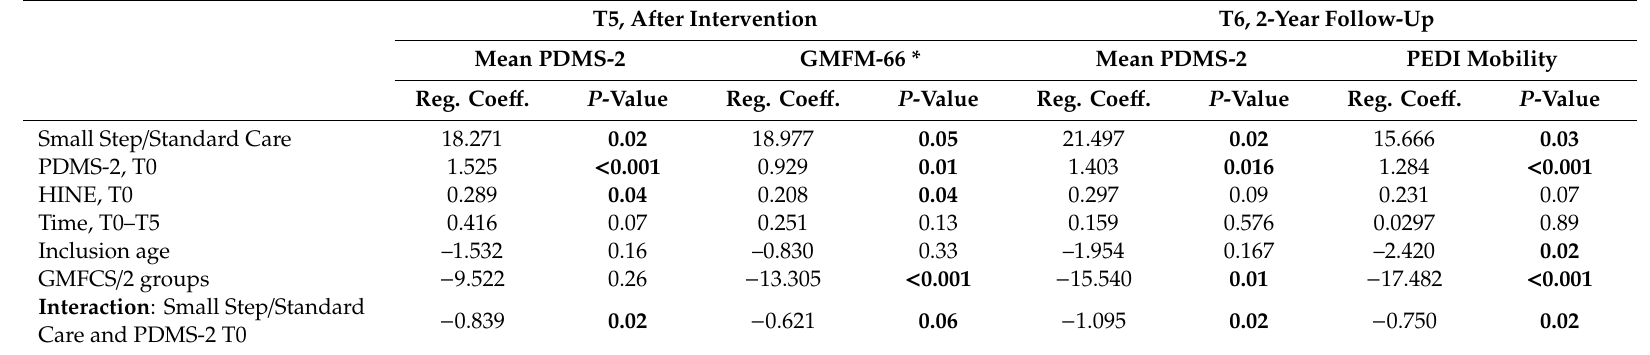
Table 3. Final linear model analysis with PDMS-2 as the outcome at post intervention (T5) and at 2 years of age (T6). The models for secondary outcomes, GMFM-66, and the PEDI mobility scale are also